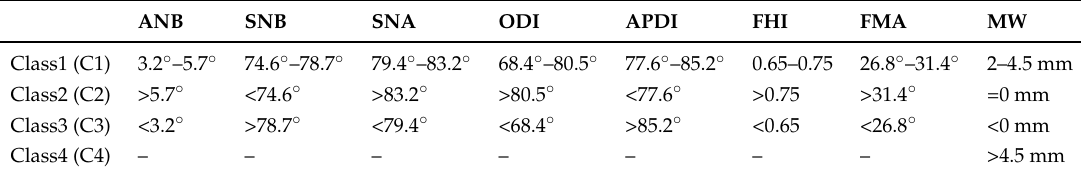
Table 6. Classifications for 8 methods, ANB, SNB, SNA, ODI, APDI, FHI, FMA and MW.